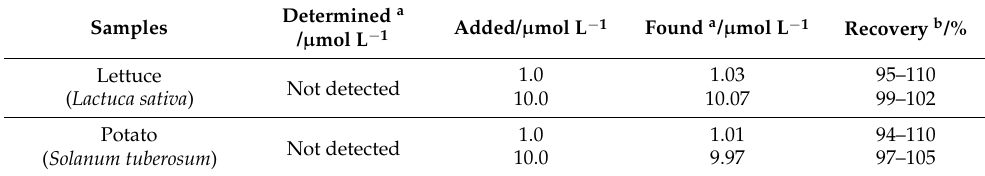
Table 2. Determination of the level of BTL in fresh samples using the ratiometric